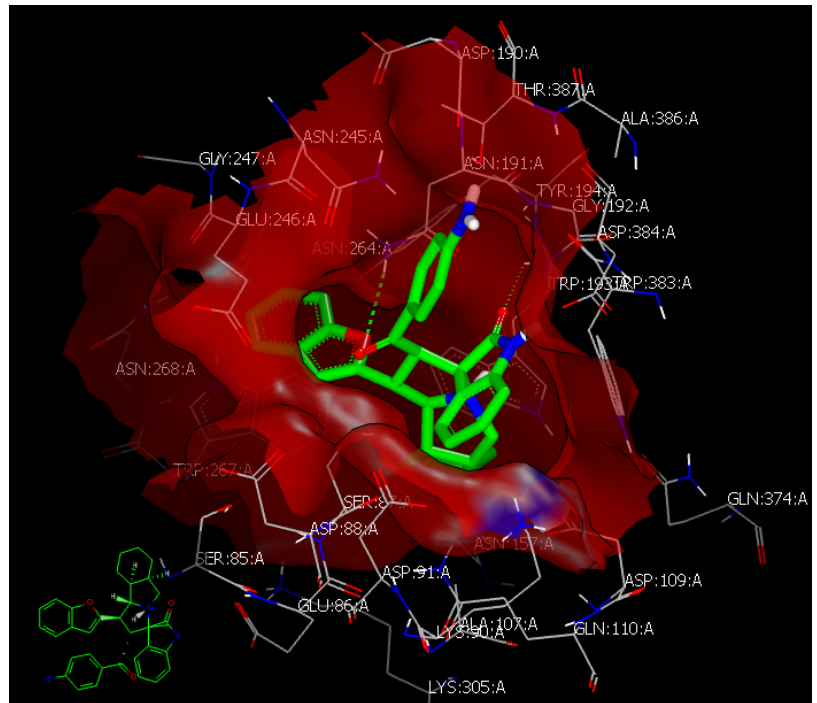
Figure 2. Vida visualization representing the amino acids in the binding site of the active site (ID: 4UAC) that interact with ligand 5r .